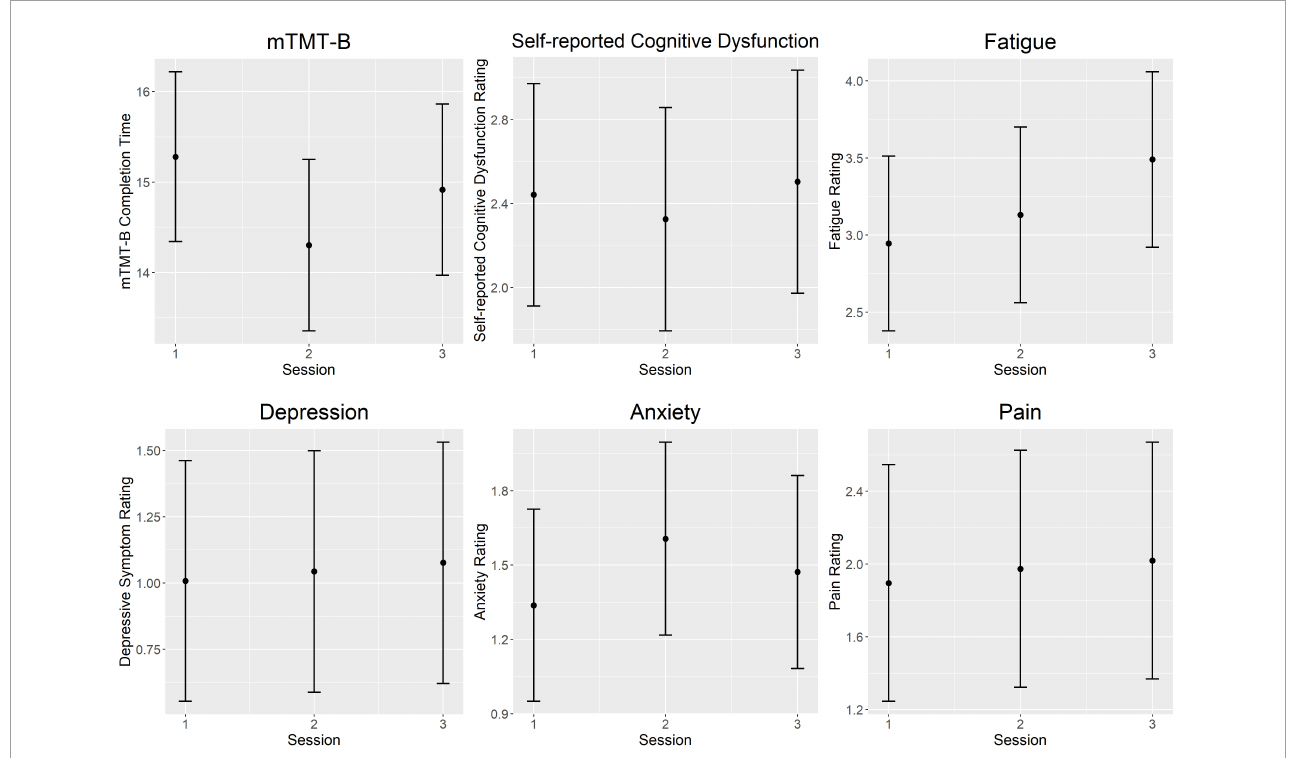
FIGURE2 Intra-day fluctuations of symptom severity. Both objectively and subjectively measured cognition was worse in the morning and end of day compared to the middle of the day. Anxiety ratings showed the opposite trend and peaked at mid-day. Fatigue ratings increased steadily throughout the day. There were no significant intra-day variations in ratings of pain and depressive symptoms. Each plot represents predicted values from multilevel models for the session fixed effect. Error bars represent 95% confidence intervals. mTMT-B, mobile Trail-Making Test part